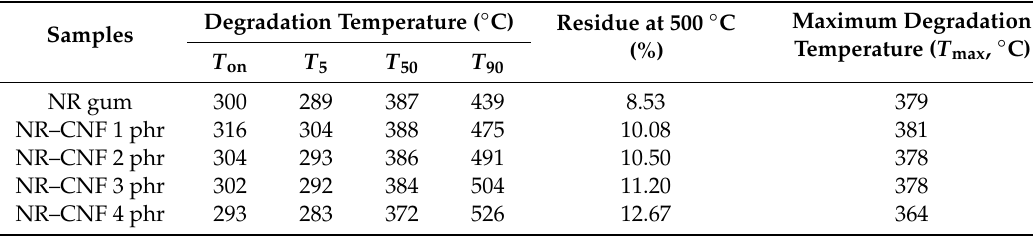
Table 6. Thermal stability of NR–CNF